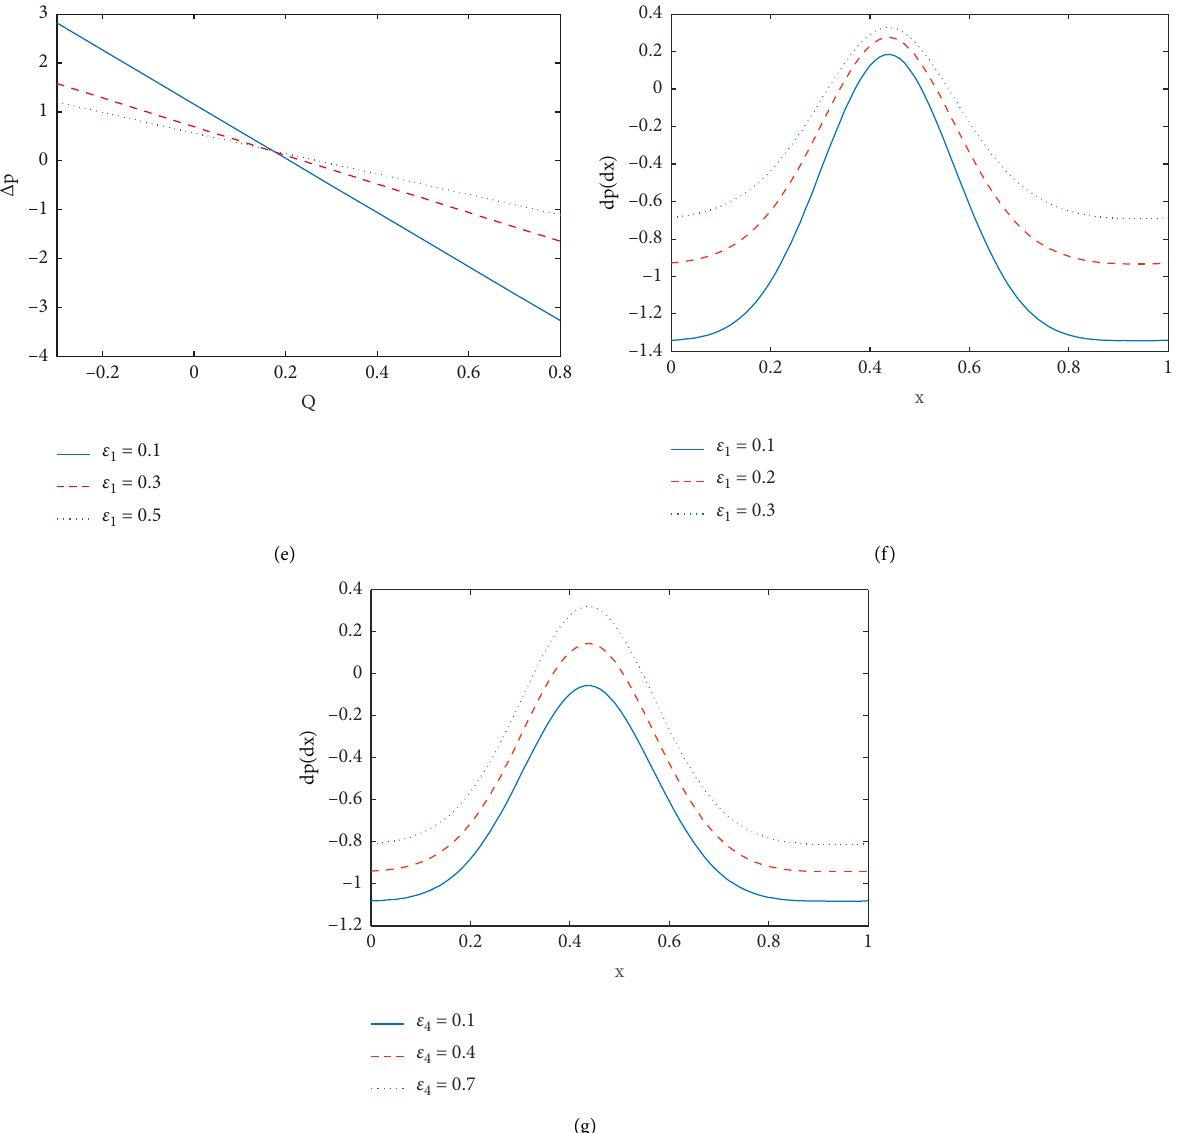
Figure 7: Effects of slip parameters on u , θ , c , Ω , Δ p , and dp / dx